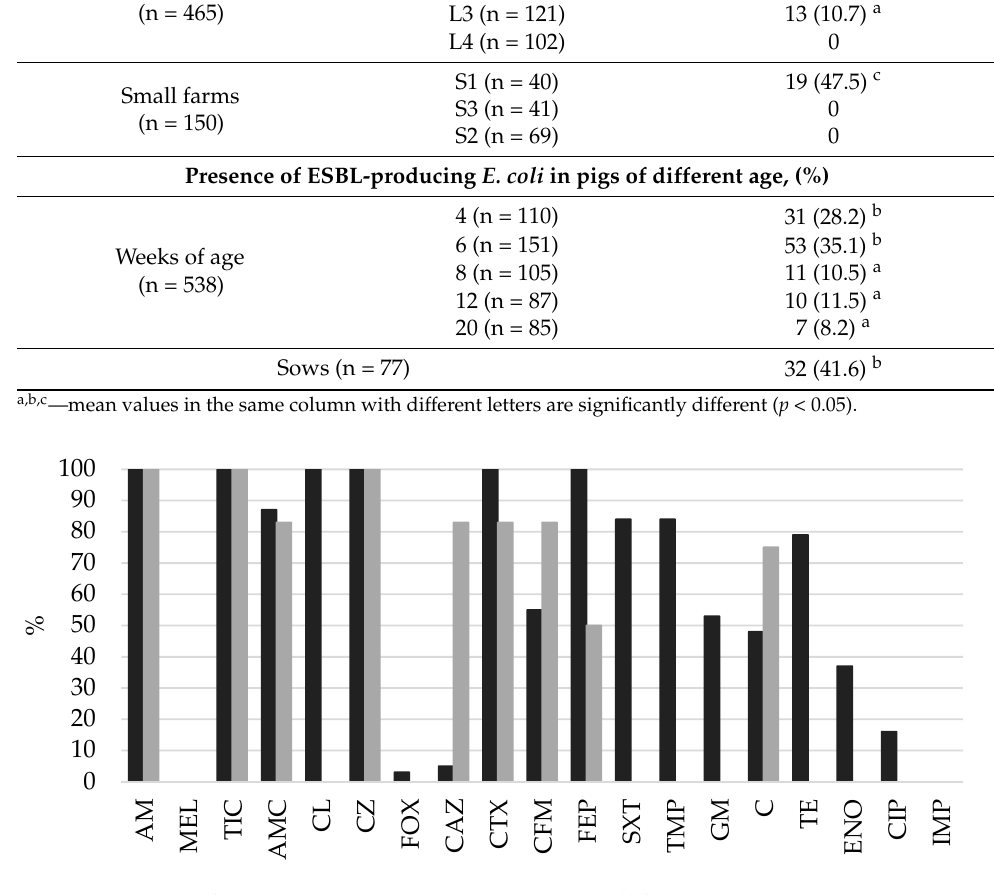
Table 1. Prevalence of ESBL-producing E. coli on pig farms. a,b,c —mean values in the same column with different letters are significantly different ( p < 0.05). Site Positive Presence of ESBL -producing E. coli on large and small pig farms, (%) Large farms (n = 465)